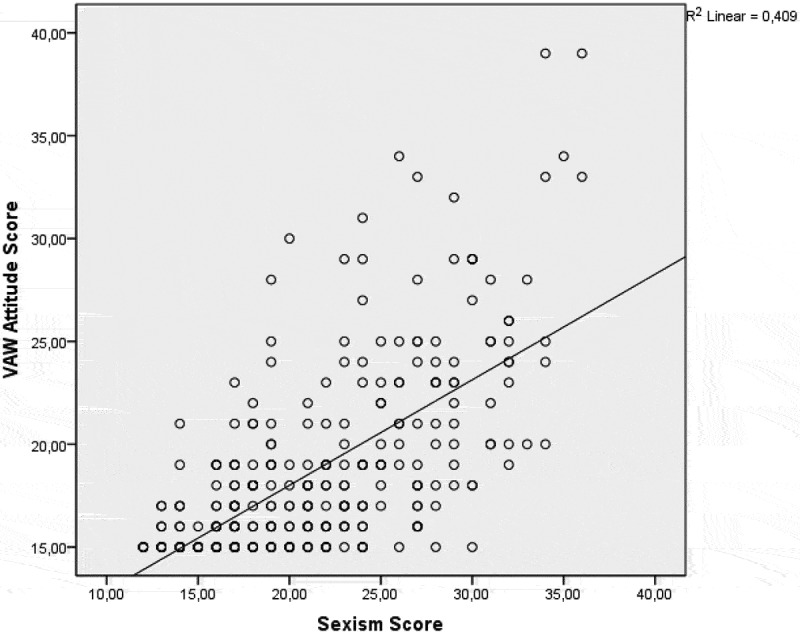
Correlation between VAW attitude scores and sexist attitude scores.